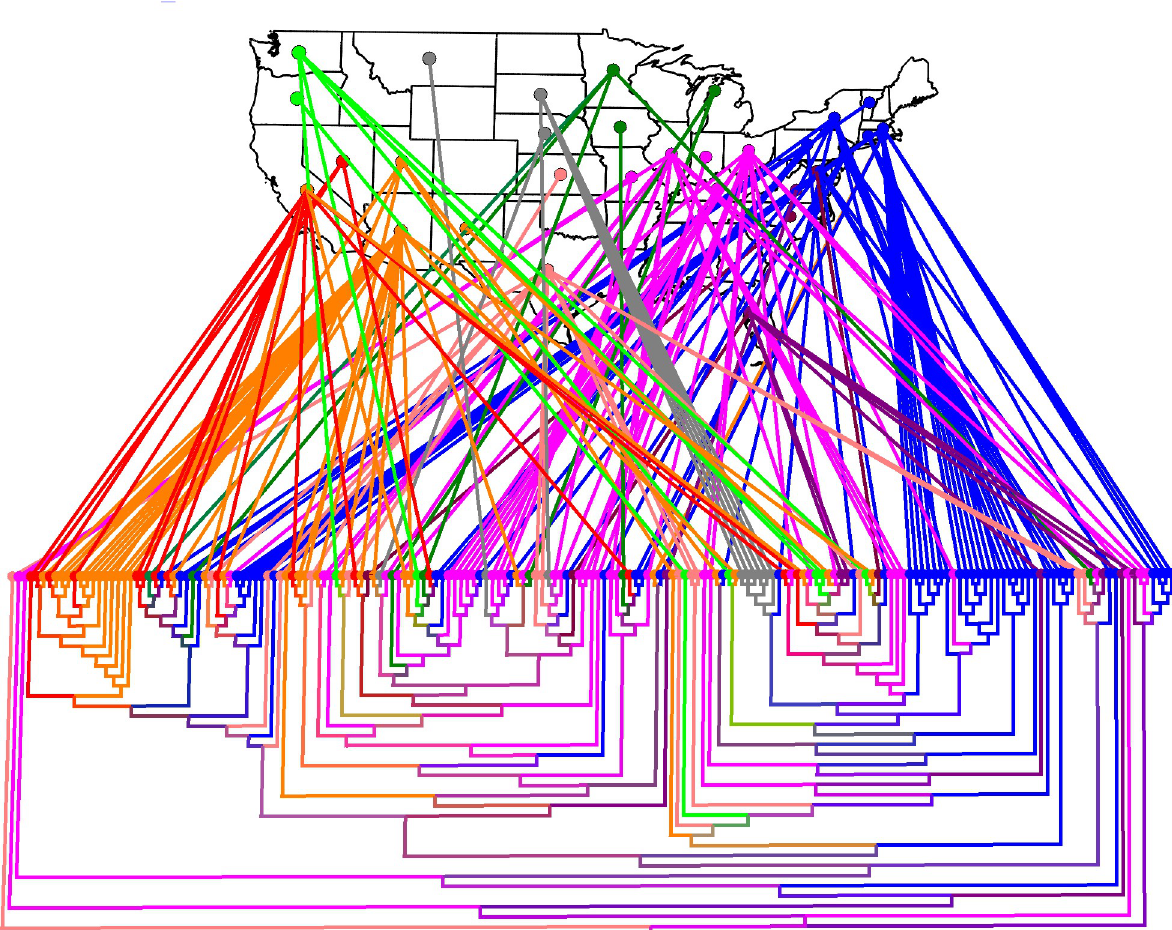
Fig 5. Phylo-geographical clustering of L . pneumophila serogroup 1, ST1 isolates from the US. Analysis conducted with 799 core, non- recombinant SNPs obtained from 187 isolate sequences after applying the Gubbins algorithm (See Methods). Colors were generated automatically in GenGIS to distinguish isolates based on the 9 NOAA climate regions. Regions and matching colors lines and branches include: Northwest, bright green; West North Central, grey; East North Central, dark green; Northeast, blue; West, red; Southwest, orange; South, salmon; Southeast, maroon; Central, bright pink. Isolates from Hawaii and Alaska are not represented in this